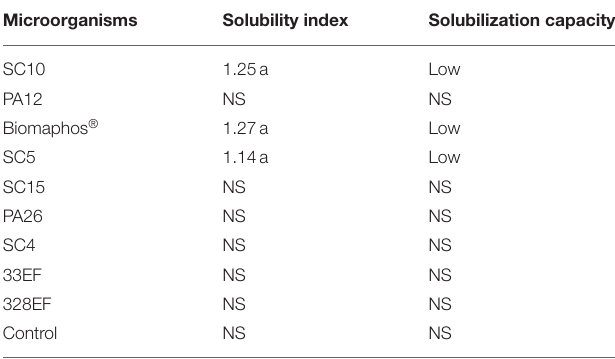
TABLE 2 | Evaluation of calcium phosphate (CaHPO 4 ) solubilization in solid medium (GELP) by rhizospheric or endophytic bacterial and fungal strains from